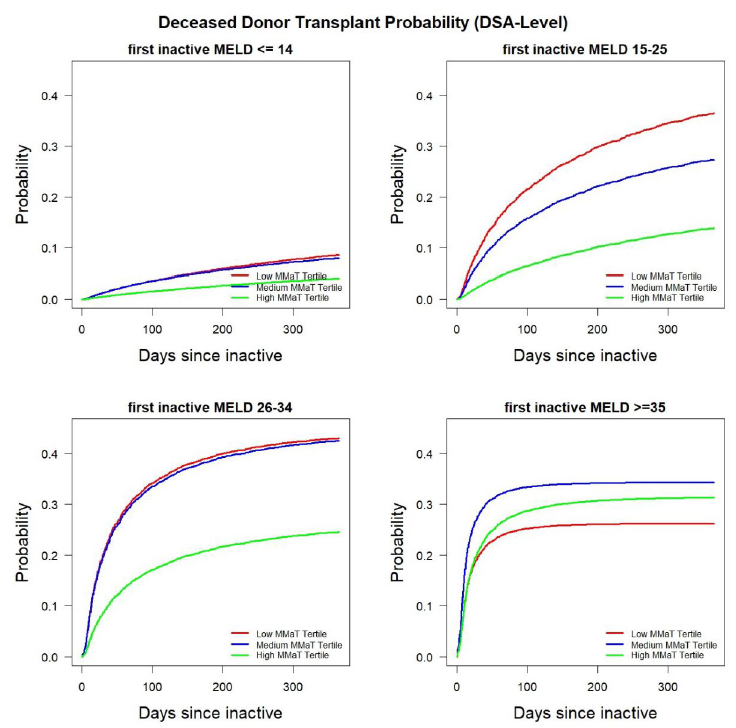
Fig 2. Probability of receiving deceased donor transplant among inactive waitlist candidates stratified by candidate MELD group and MMaT at the DSA-level.